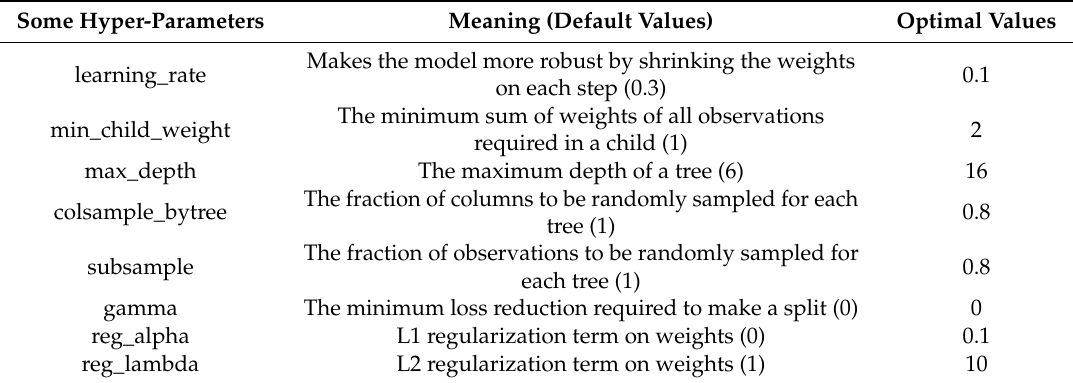
Table 1. The meaning and optimal values of some hyper-parameters of the XGBoost